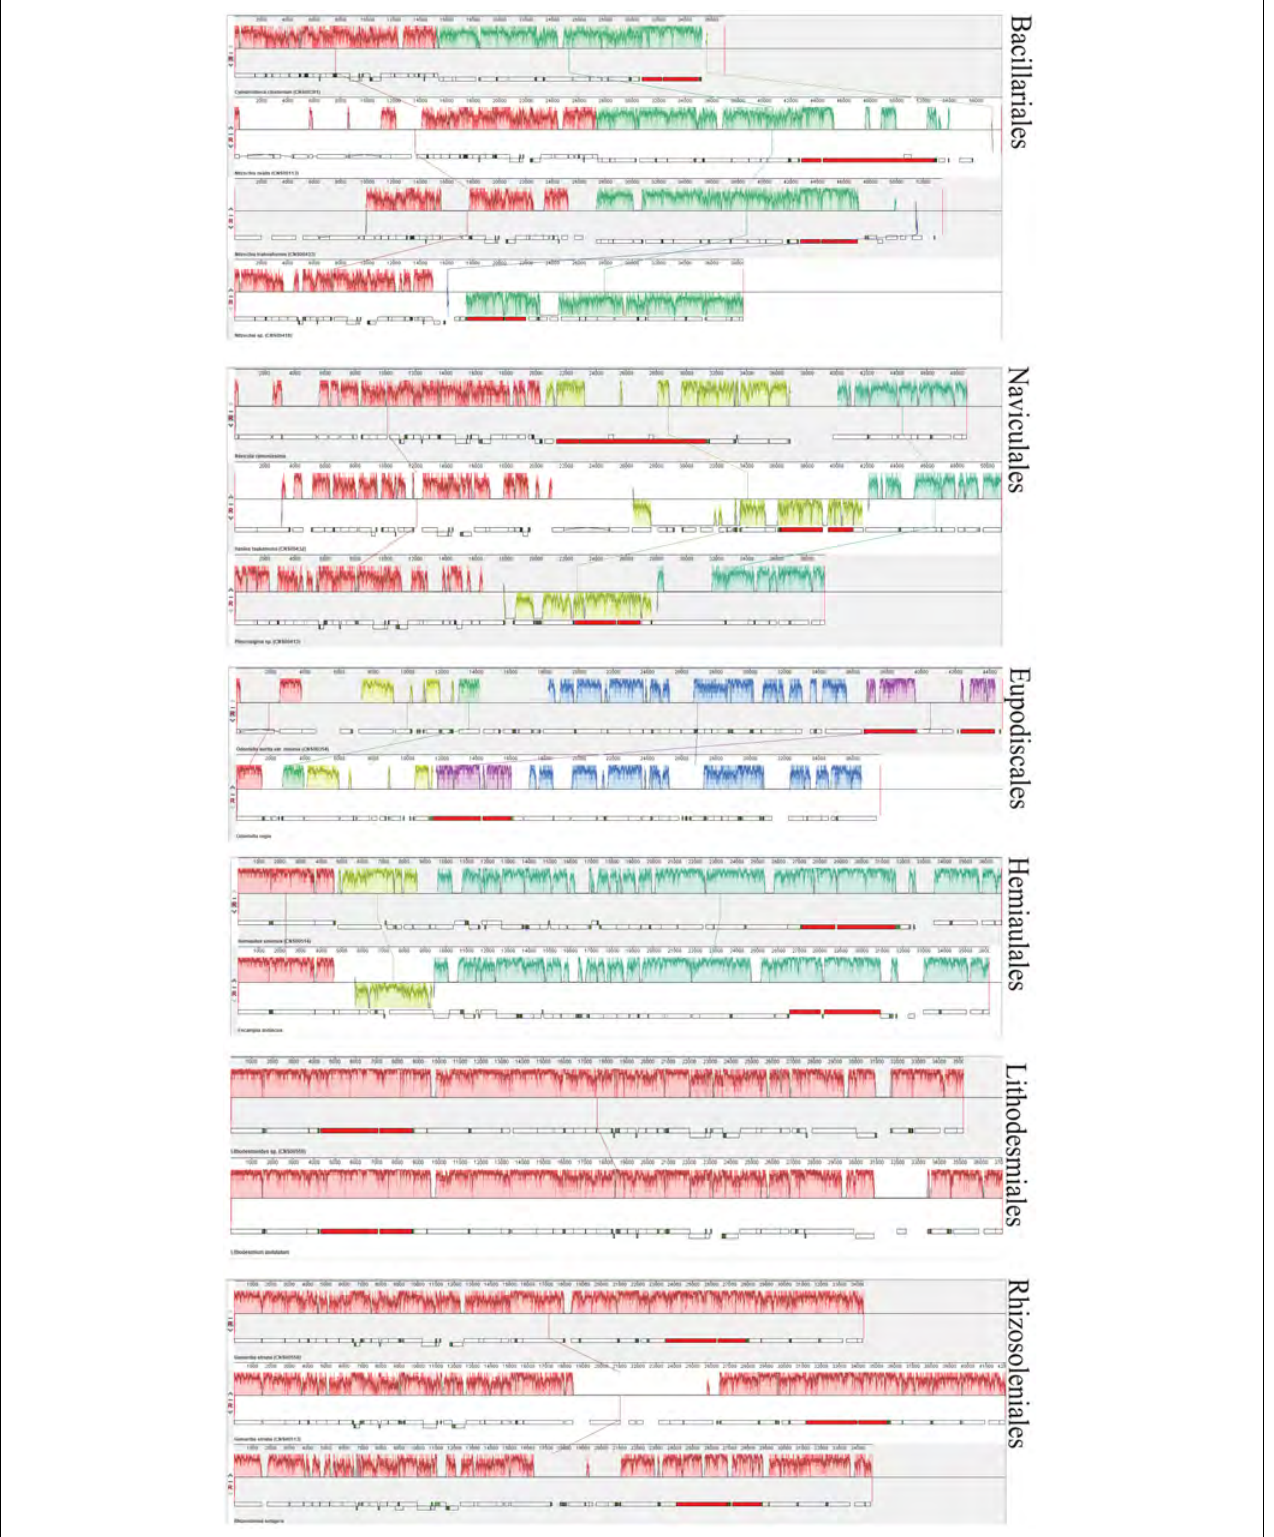
FIGURE 8 | Synteny relationships using Mauve analysis for six orders of diatoms (Bacillariales, Naviculales, Eupodiscales, Hemiaulales, Lithodesmiales, and Rhizosoleniales) that included mtDNAs constructed in this study. Each colored block indicates a synteny block among different mitochondrial genomes.